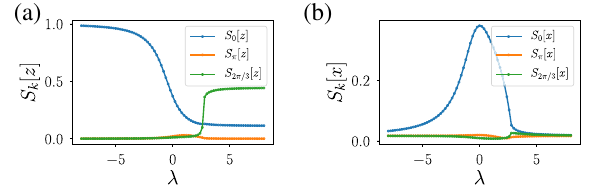
FIG. 6. The ground state of the 1D PXP model. (a) Structure factors for z spin-spin correlations for k ¼ 0 ; π ; 2 π = 3 . (b) Struc- ture factors for x spin-spin correlations for k ¼ 0 ; π ; 2 π = 3 . 60 and maximum bond dimension D ¼ 128 Parameters: N x ¼